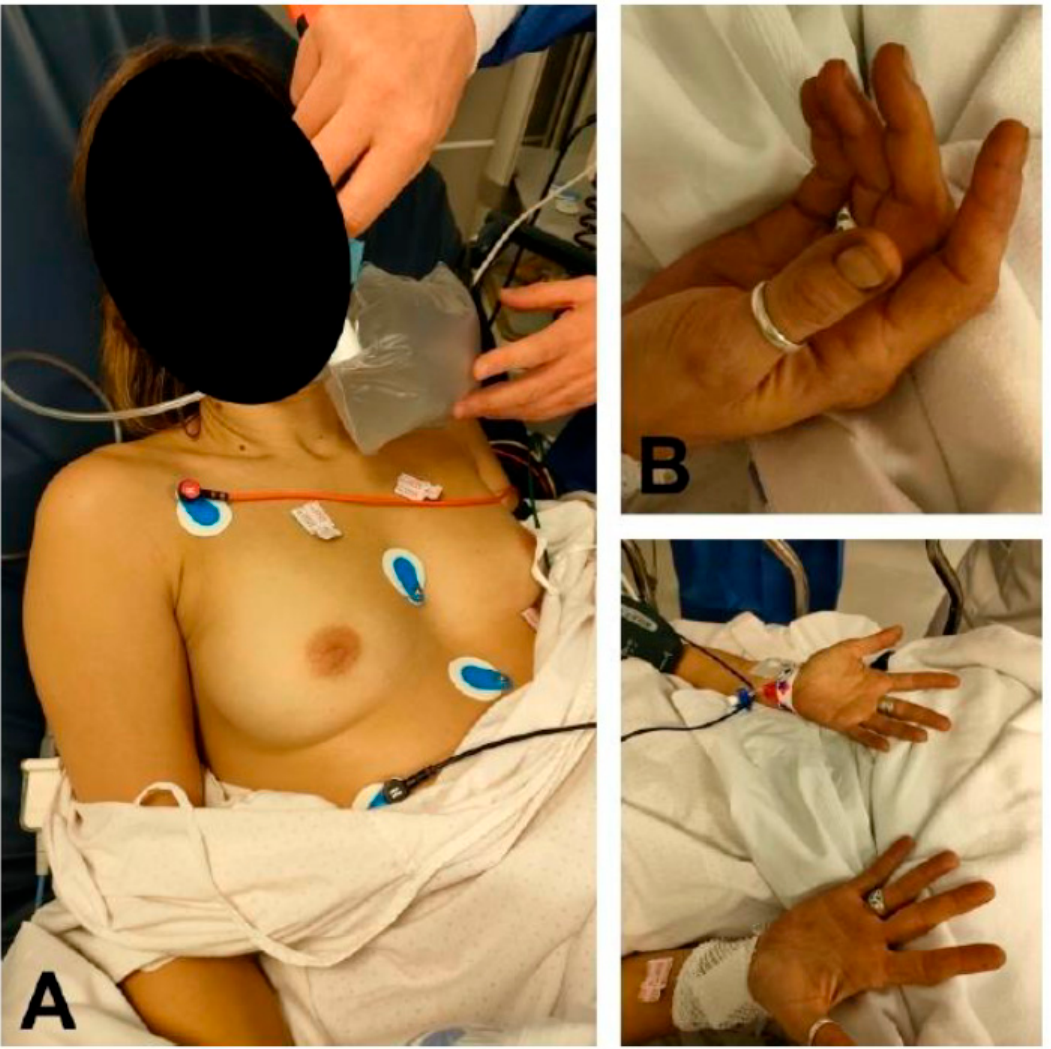
Figure 1. Patient with methemoglobinemia secondary to inhalation of gases from a vehicle engine. ( A ) Cyanotic discoloration of the patient’s skin compared to the skin on the back of the physician’s hand. ( B ) Peripheral cyanosis. Note the grayish discoloration of the patient’s nail beds.